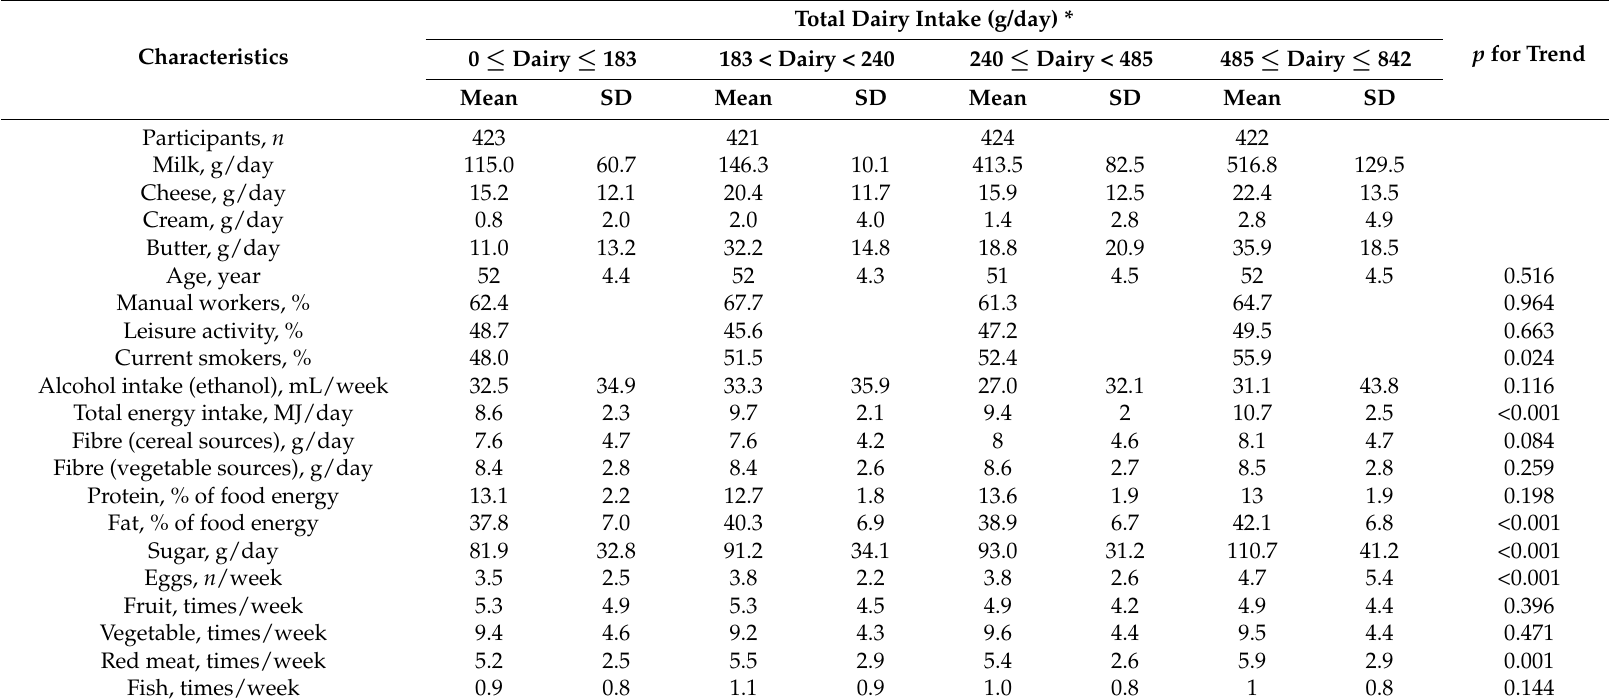
Table 1. Background characteristics according to quartile of baseline total dairy product